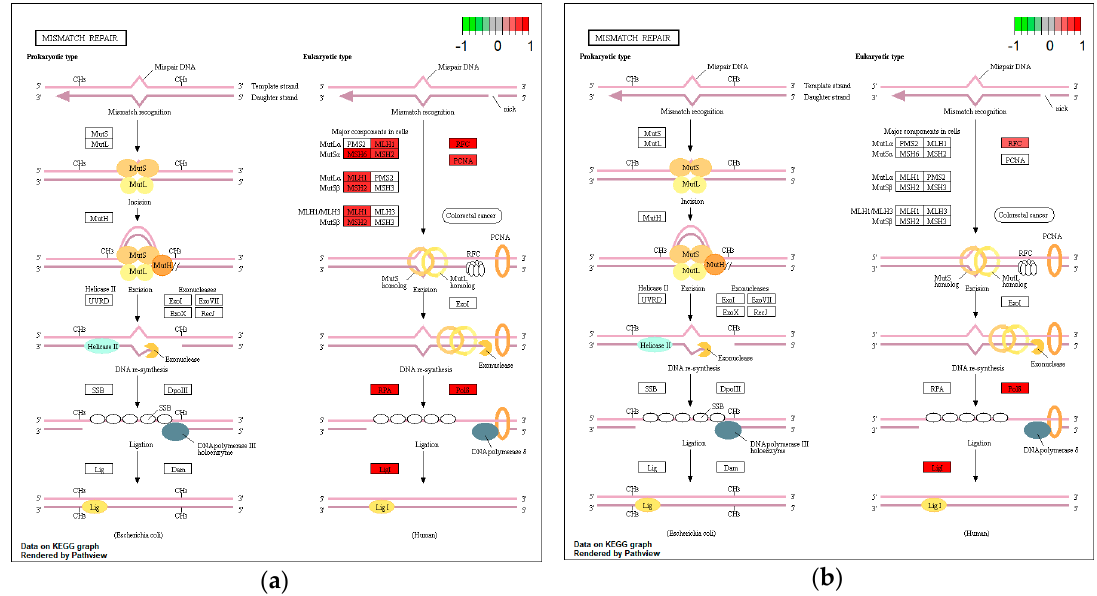
Figure 4. Impact of H. pylori infection ( a ) and CagA protein ( b ) on gene expression of mismatch repair